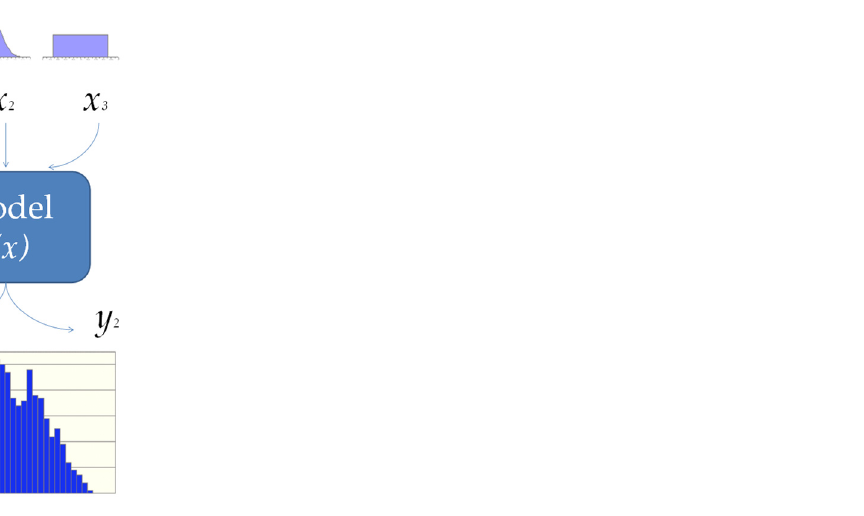
Figure 2. Outputting reliability, tolerance, and confidence interval with simulation. Data source: Wittwer